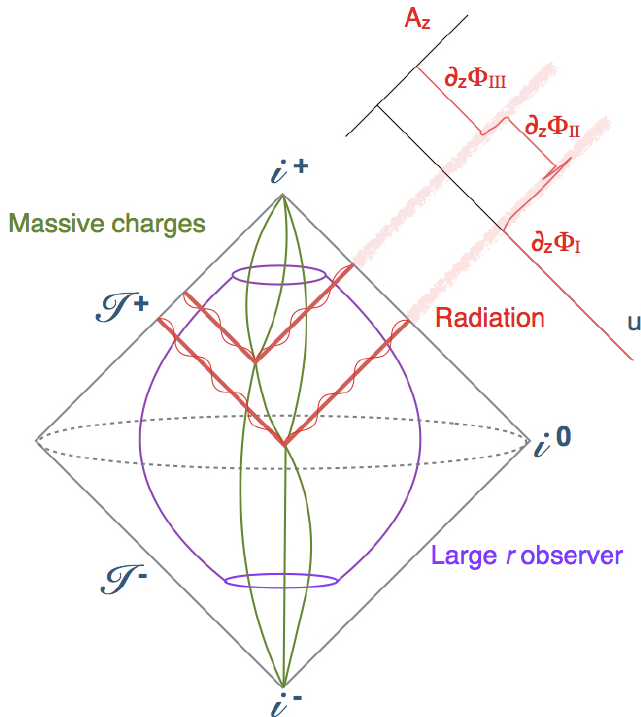
Figure 1 . Radiation resulting from the acceleration of